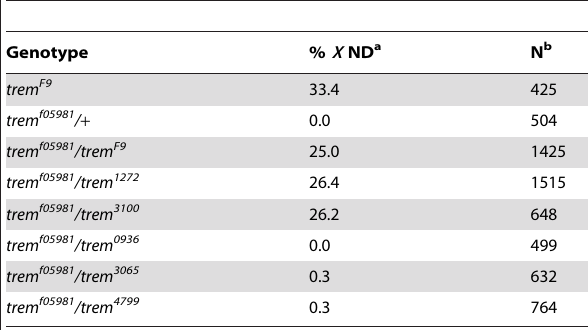
Table 1. Segregation defects associated with genomic trem alleles.